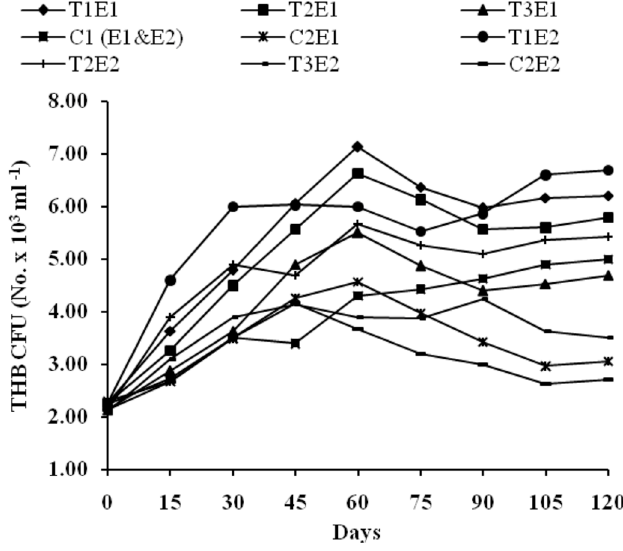
Fig. 7. Temporal changes of THB in water inthe treatments of E1 and E2.